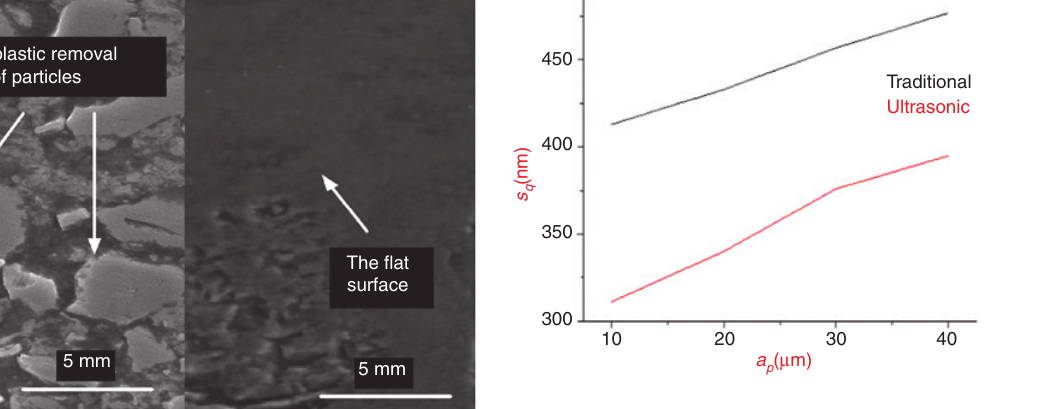
: traditional vs. ultrasonic. Figure 8: Grinding S q